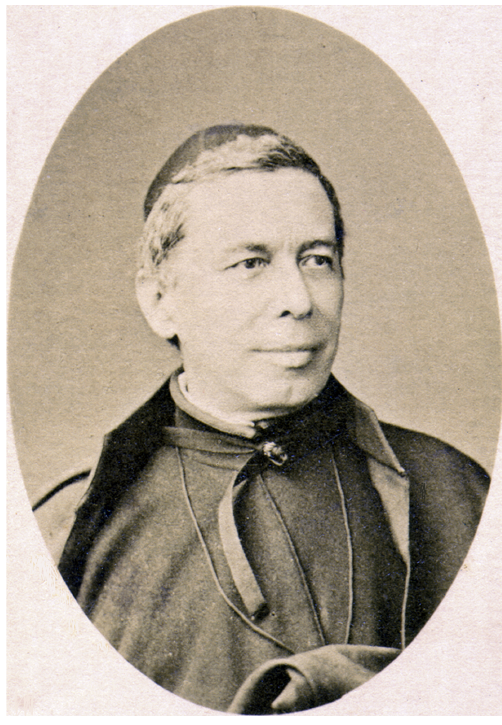
Figure 2. Father Pietro Angelo Secchi (1818–1878).